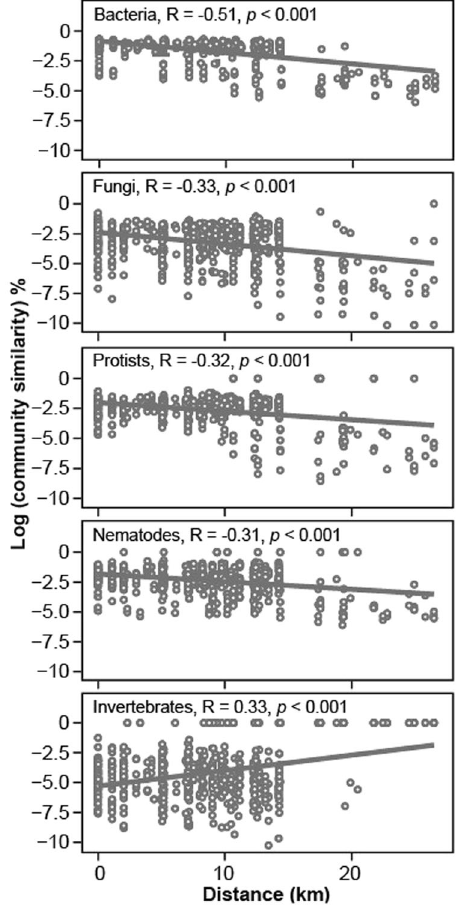
Fig. 2 Distance-decay relationships (distance – decay relation- ships) of soil biota in a subtropical urban region of Xiamen, China. The Mantel statistic R and the signi fi cance levels ( p ) are presented. Signi fi cant negative Mantel ’ s r values indicate decrease of similarity between any two sites as the distance between them increases. Bray – Curtis similarity matrices were calculated using rare fi ed ASVs tables, log-transformed, and plotted against the geographical